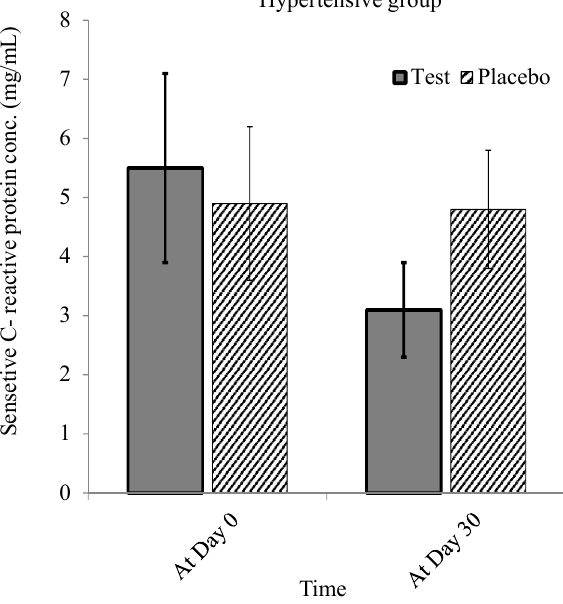
Fig. 4. Sensitive C-reactive proteins levels for the hy- pertensive group receiving anthocyanin extract or placebo at day 0 and day 30. Values are expressed as mean